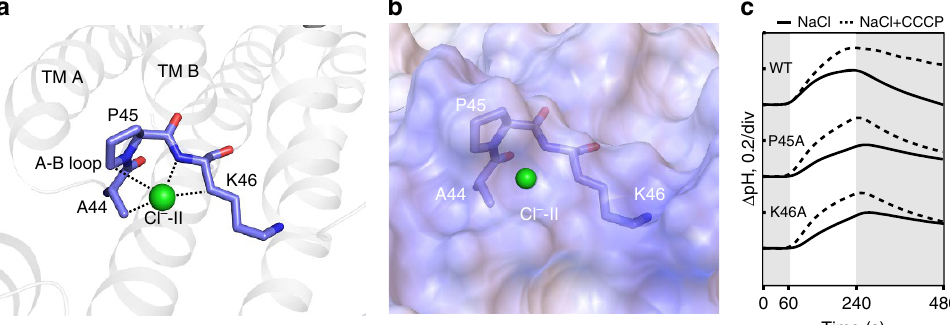
Figure 4 | Chloride ion-binding site on the cytoplasmic loop of ClR. ( a ) Coordination of Cl (cid:2) -II (green sphere) by Ala44, Pro45 and Lys46. Dotted lines represent hydrogen-mediated bonds. ( b ) Surface electrostatic potential around Cl (cid:2) -II-binding site. ( c ) Light-induced pump activities of wild-type (WT) ClR and its mutants at Pro45 and Lys46. The pumping activities are measured in NaCl (lines) and NaCl with carbonyl cyanide m -chlorophenylhydrazone (CCCP; dashed lines). Grey and white sections indicate dark and light conditions,